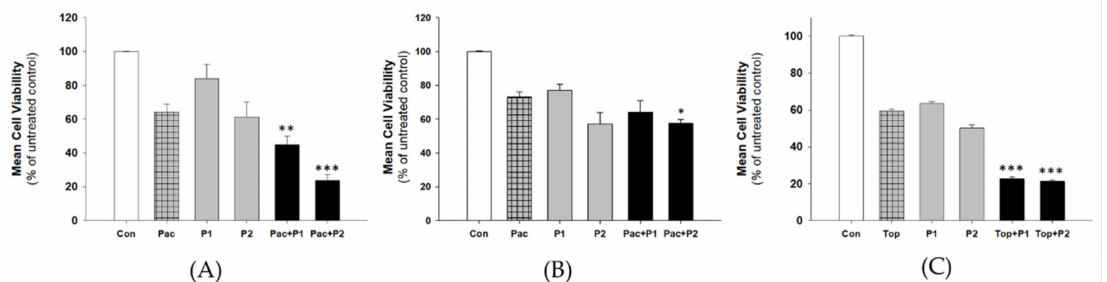
Figure 2. Piperine sensitizes drug-resistant cell lines to chemotherapy in vitro. Cell lines resistant to PAC–W1PR1 ( A ) and W1PR2 ( B ) and TOP ( C ) were seeded in 96-well plates. Cells were treated for 72 h with PAC (500 ng/mL = 0.59 µ M) or TOP (50 ng/mL = 0.11 µ M), piperine in concentrations P1 and P2, or with PAC/TOP and piperine together. After 72 h of treatment, cell viability was determined using MTT assay. Viability was expressed as a percent of the untreated control (mean ± SEM). Values were considered significant at * p < 0.05, ** p < 0.01 and *** p <